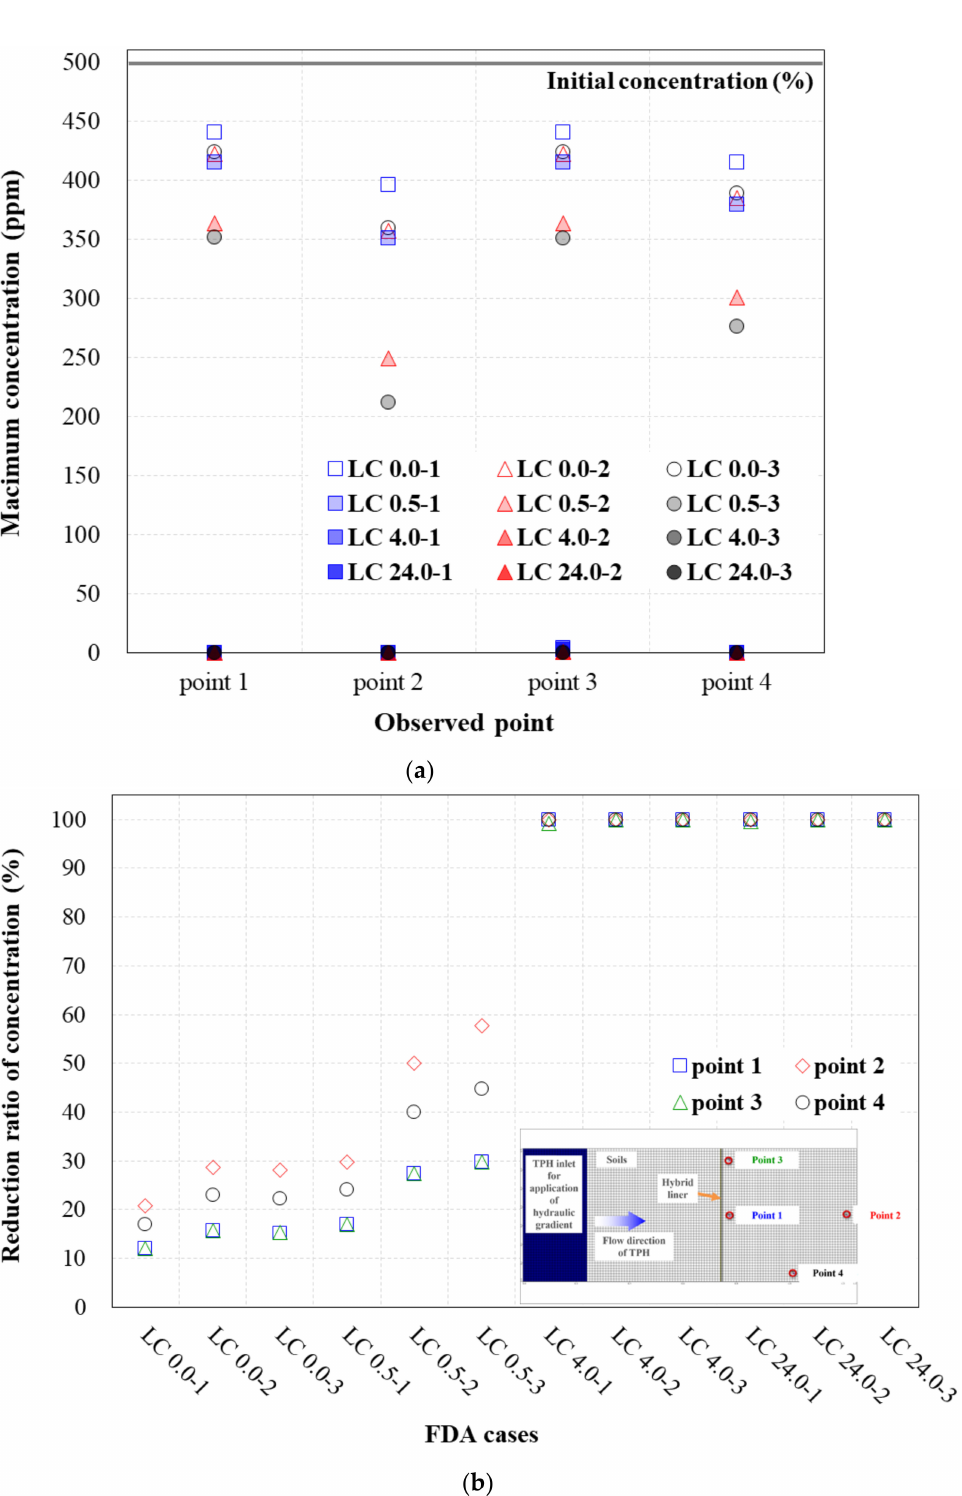
Figure 8. Concentration variance at the low-TPH condition: ( a ) Maximum concentration (ppm) at the observation point; ( b ) Reduction ratio of the concentration at the observation